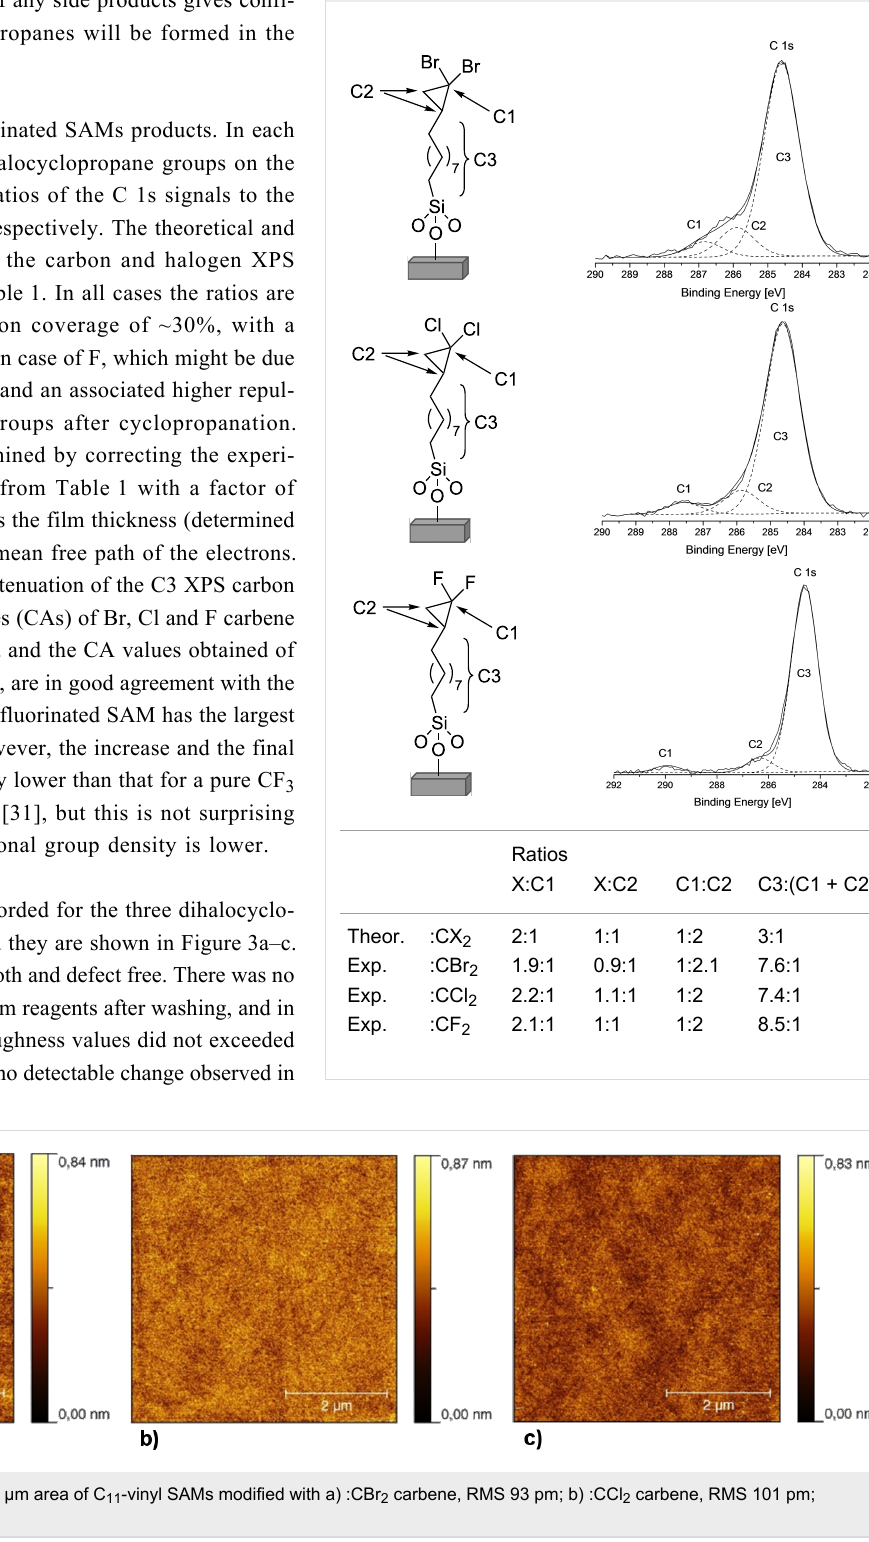
Table 1: Assignment of the C 1s XPS signals after treatment of C 11 - vinyl SAMs with the respective dihalocarbene. Theoretical and